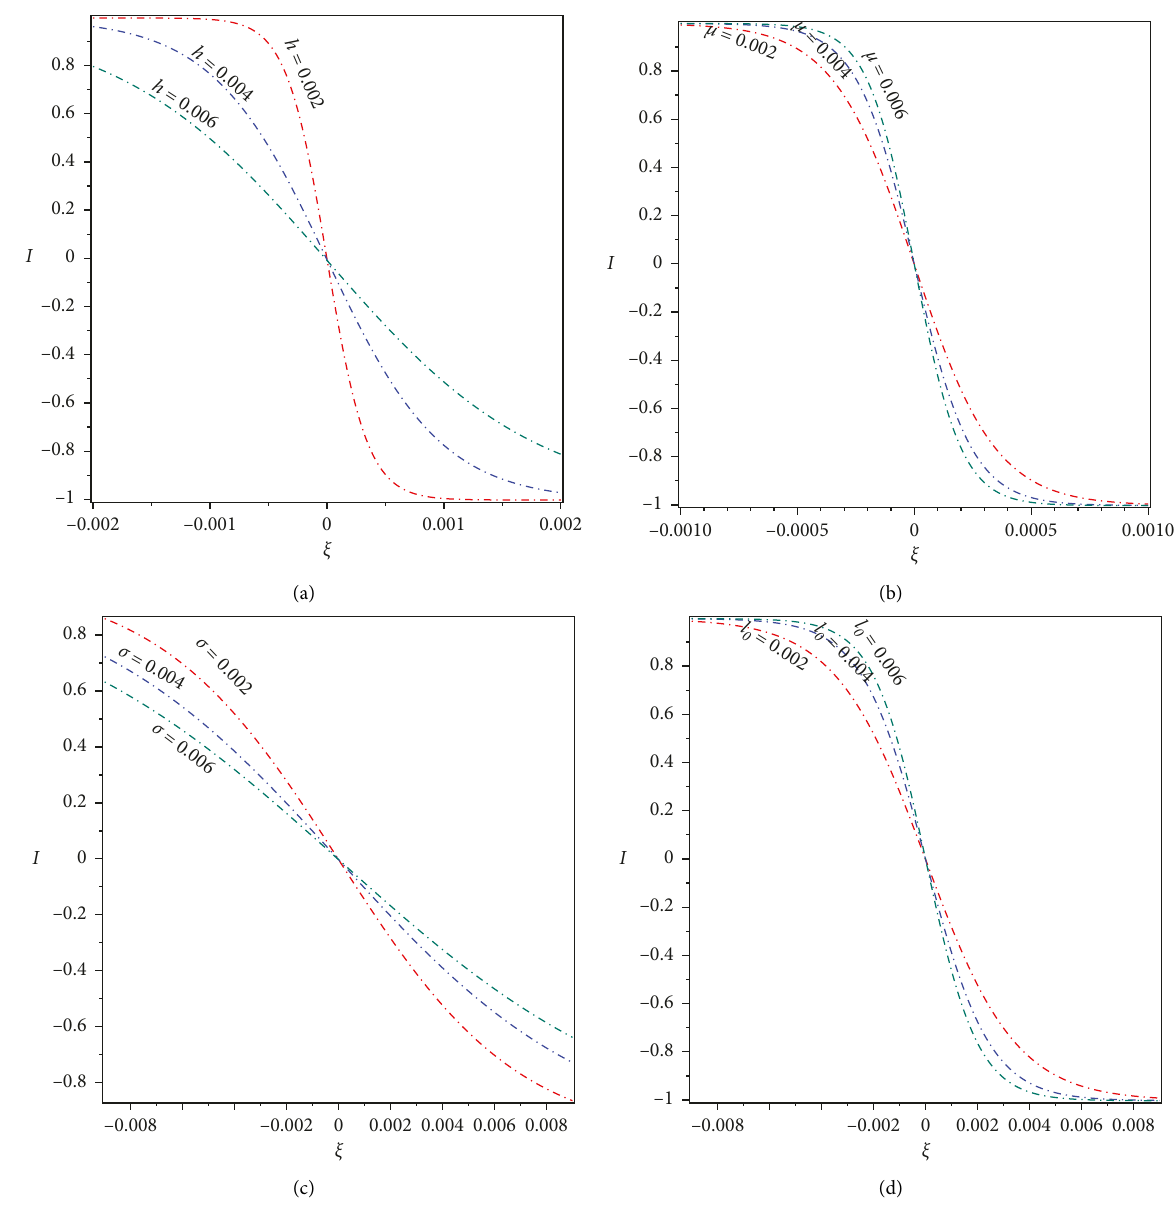
Figure 6: Parameters affecting solution (24): (a) changes in h for R in μ